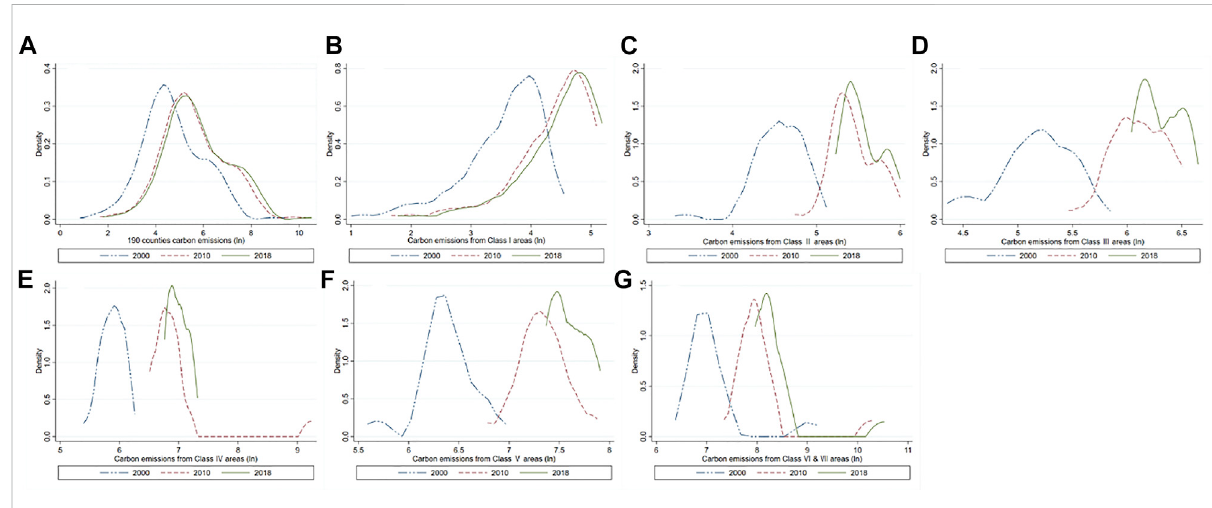
FIGURE 7 Results of kernel density analysis of carbon emissions in the Yangtze River Delta counties as a whole and at each